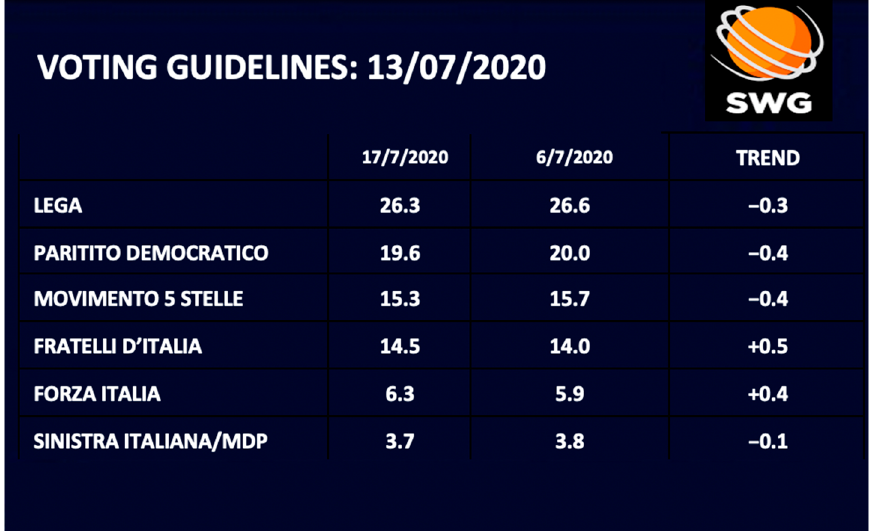
Figure 3. Polls retrieved by Swg, July 2020.